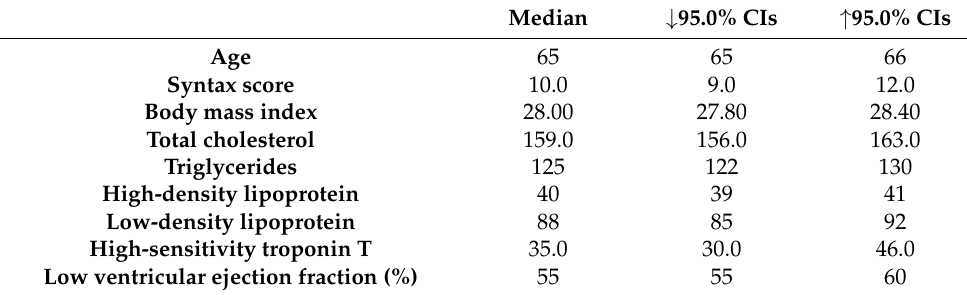
Table 2. Baseline continuous clinical characteristics of the CorLipid